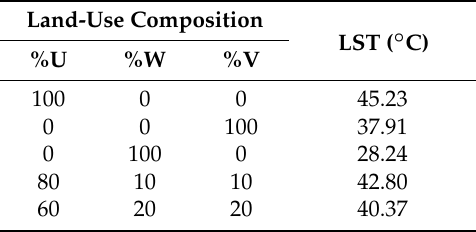
Table 10. Land-use composition-driven prediction of land surface